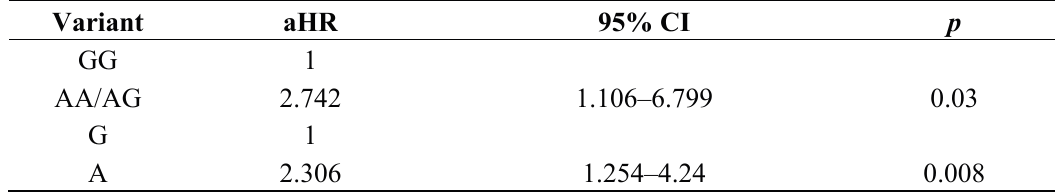
Table 2. The risks of experiencing an adverse outcome with variant SDF-1 genotype and